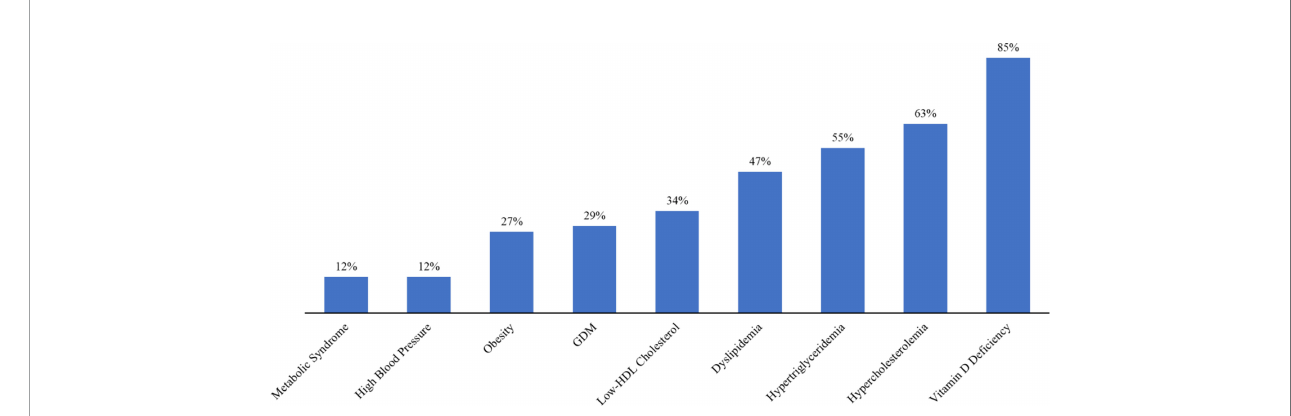
FIGURE 2 | Presence of metabolic disorders among pregnant Saudi women in their fi rst trimester.